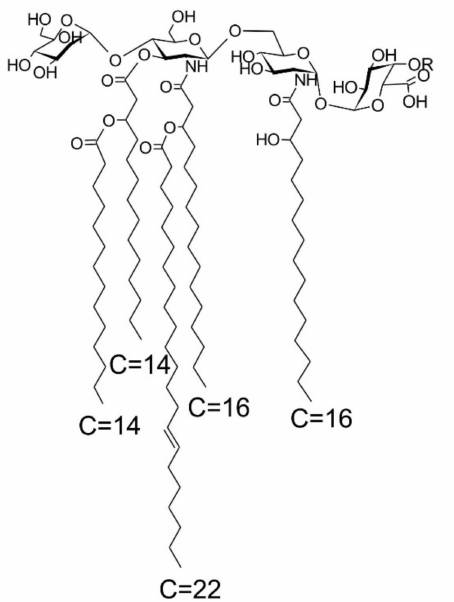
Figure 8. Proposed structure of the main component of Rv lipid A (in a molecule corresponding to the ion at m/z 1942.388 R =